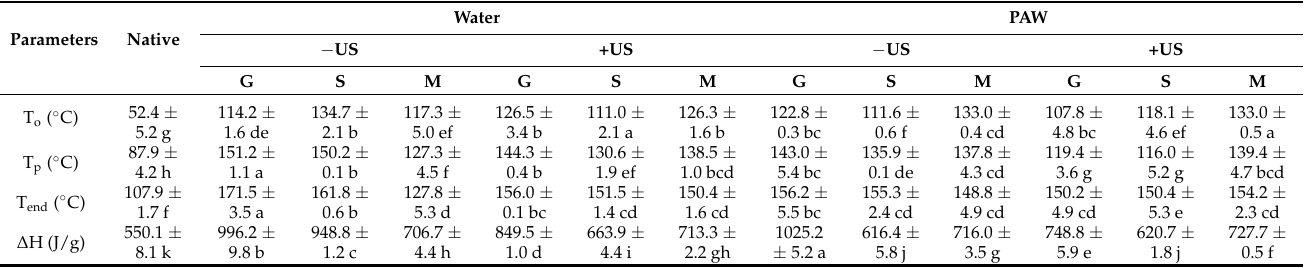
Table 1. Thermal properties of rice starch–phenolic